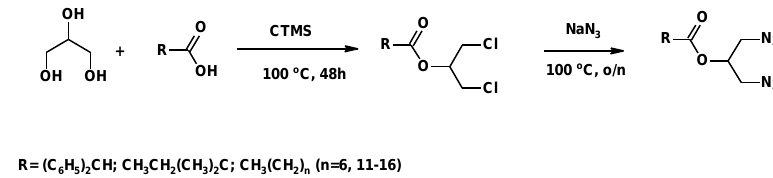
Figure 8. Synthesis of azides from glycerol and carboxylic acids.